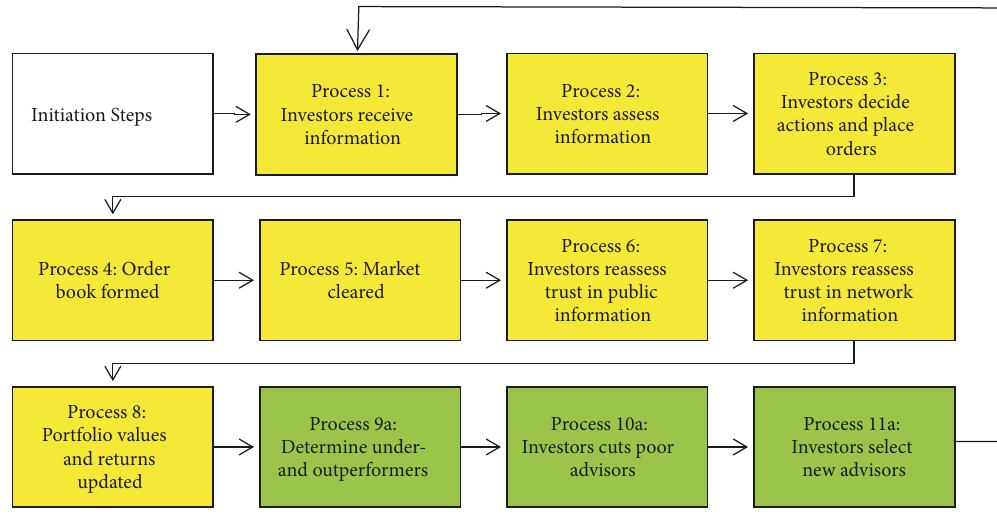
Figure 2: Representation of the model steps. Steps 9a to 11a only occur at the rewiring